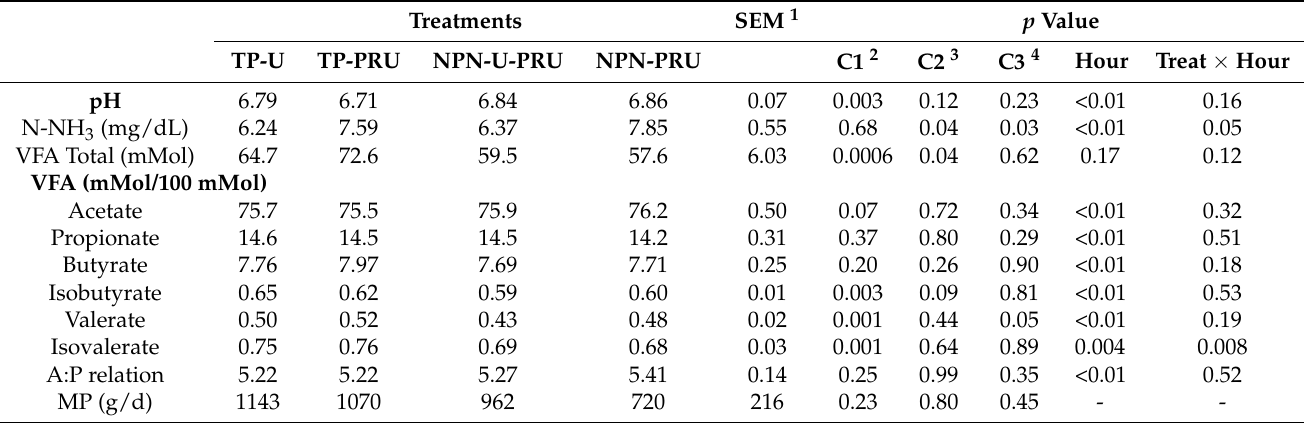
Table 4. Ruminal fermentation parameters of Nellore cattle receiving different types of supplementa- tions in Urochloa brizantha cv. Marandu during the seasonal period (exp.1). Treatments SEM 1 p